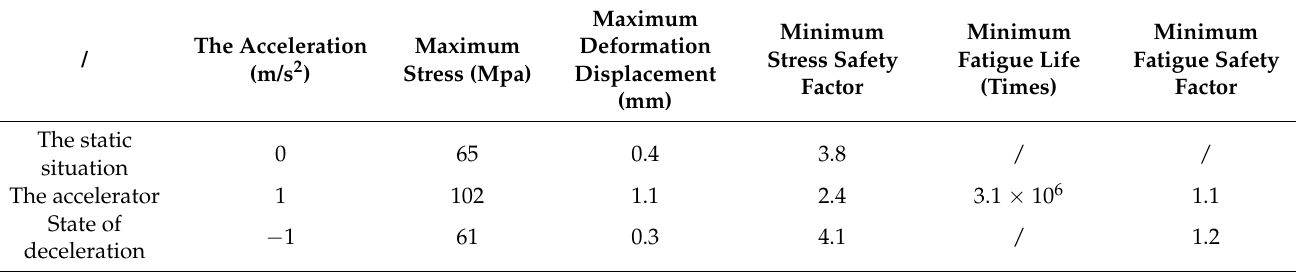
Table 3. The parameters of stacker model in various states.